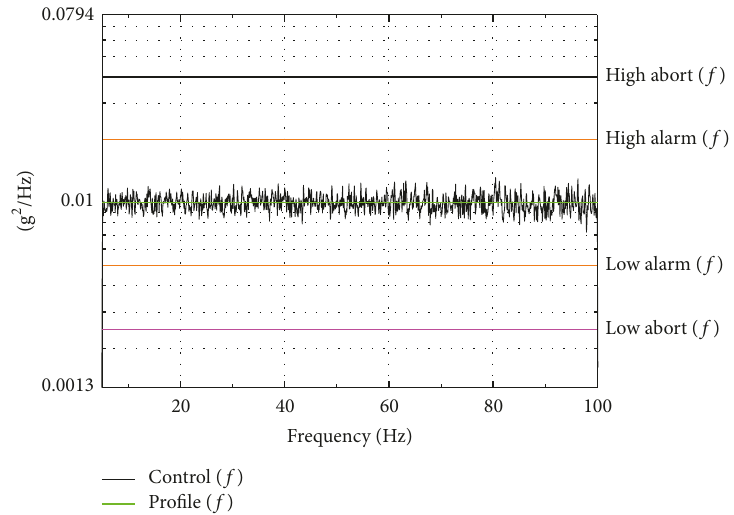
Figure 11: The autopower spectral density of vibration load.